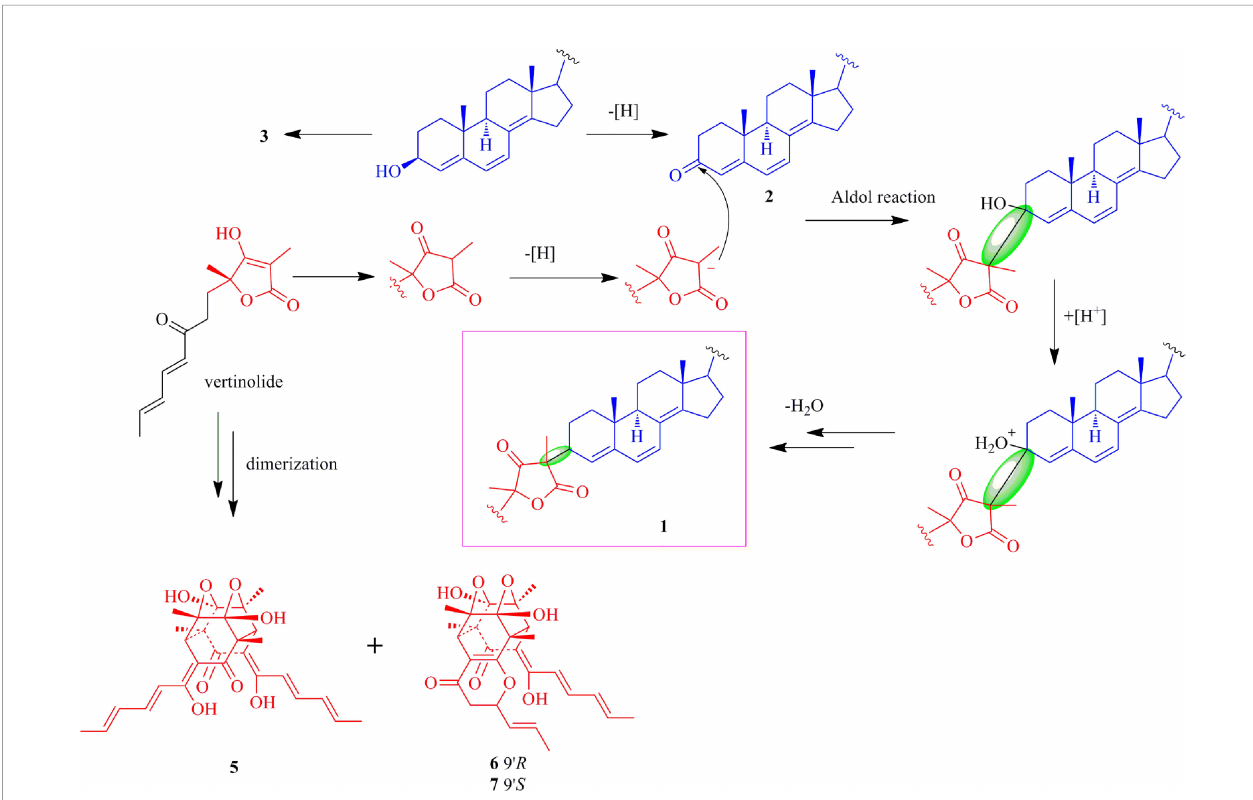
FIGURE 4 | Proposed biosynthetic pathway of 1 and related